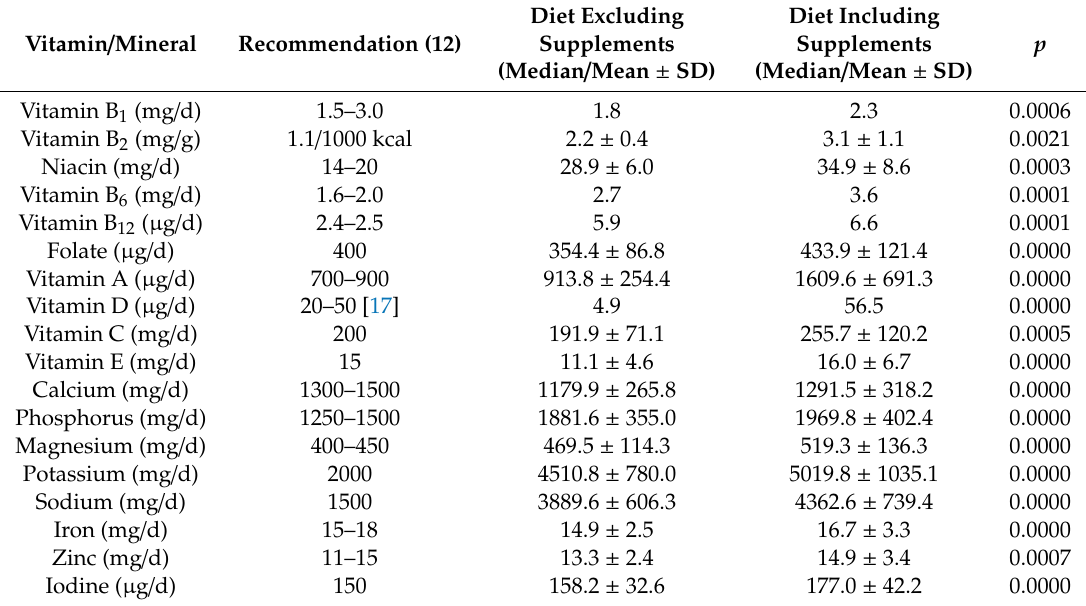
Table 5. Mineral and vitamin intake by football